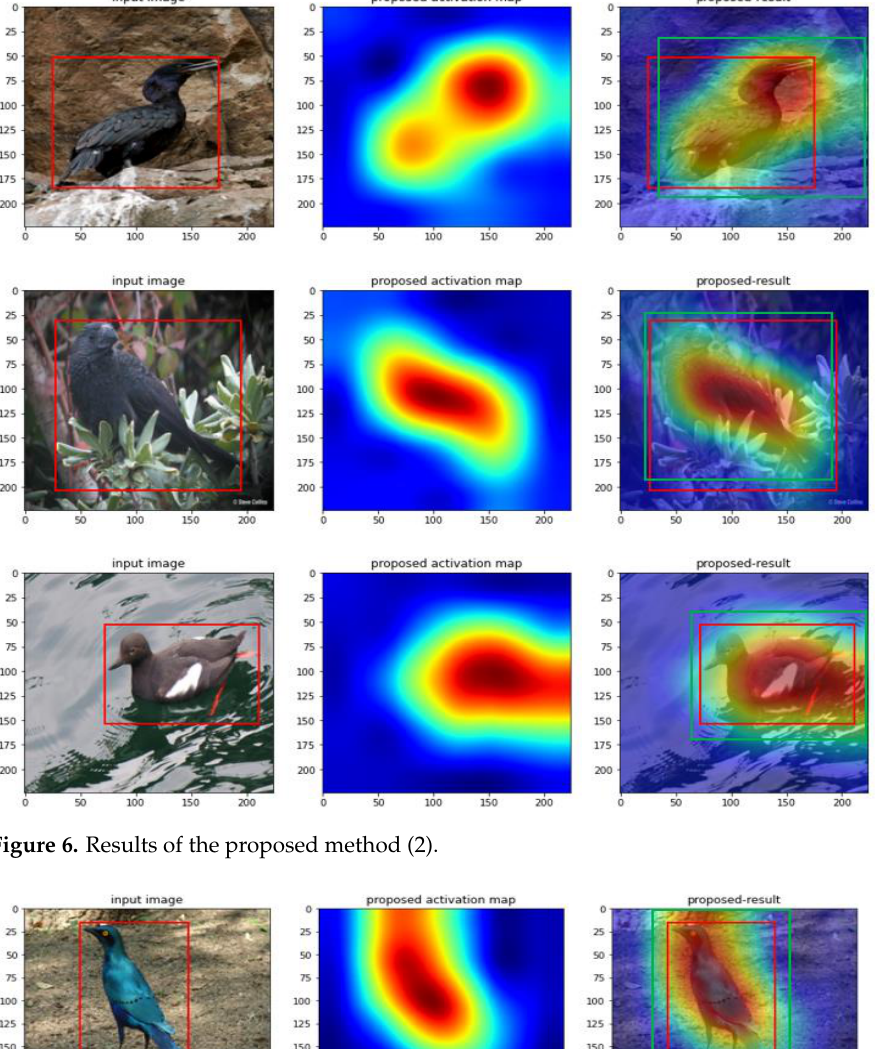
Figure 6. Results of the proposed method (2) .